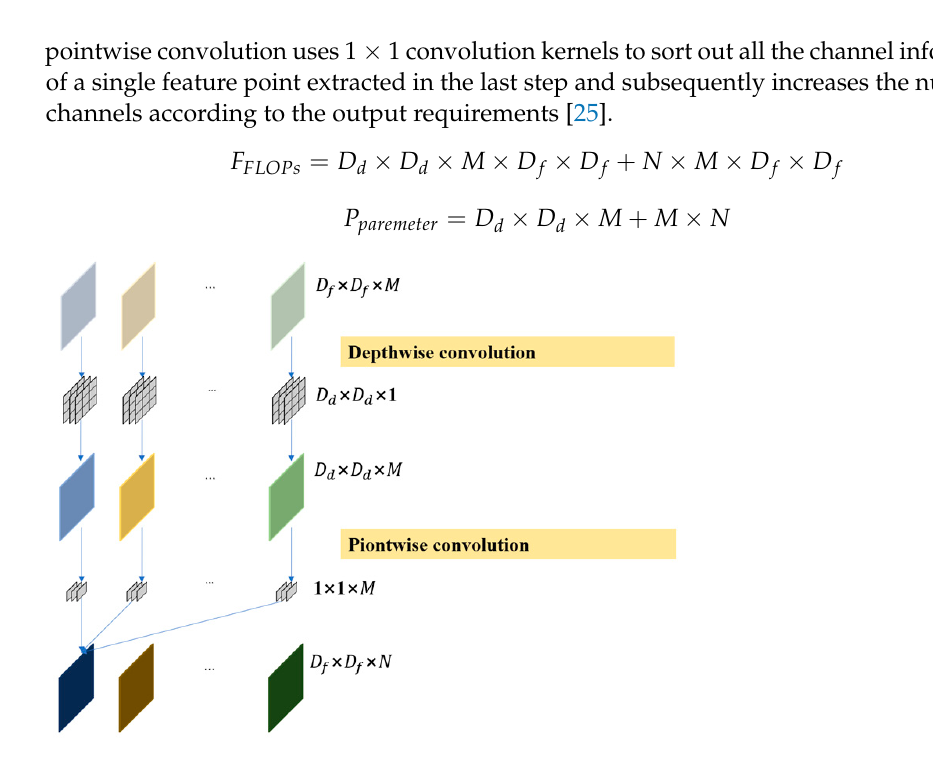
Figure 4. Deep separable convolution schematic diagram.